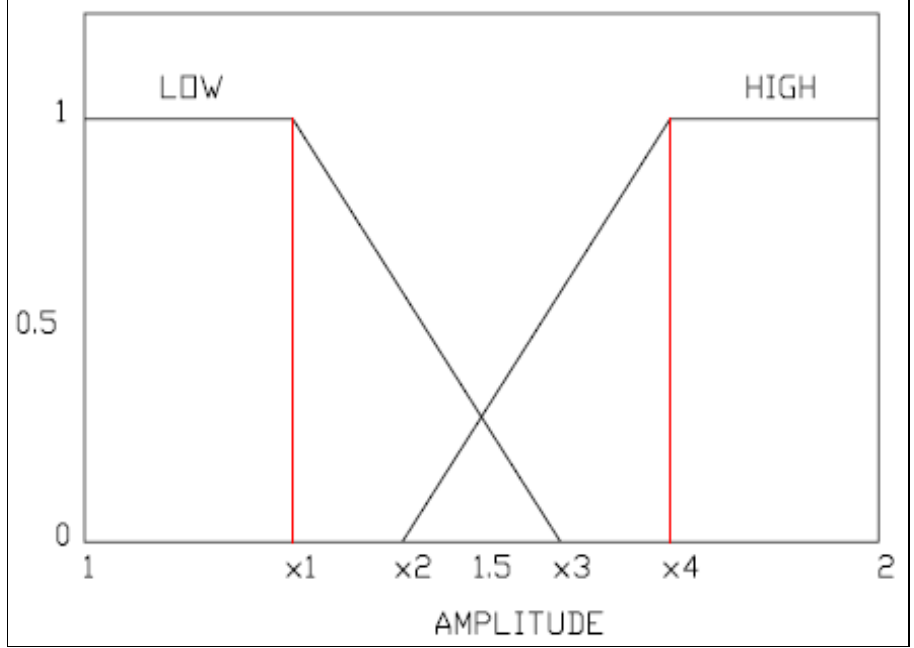
Figure 14. Two membership functions used in fuzzy system.